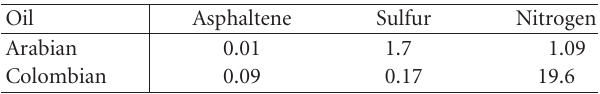
Table 1: Weight percentage of asphaltene and heteroatoms in the crude